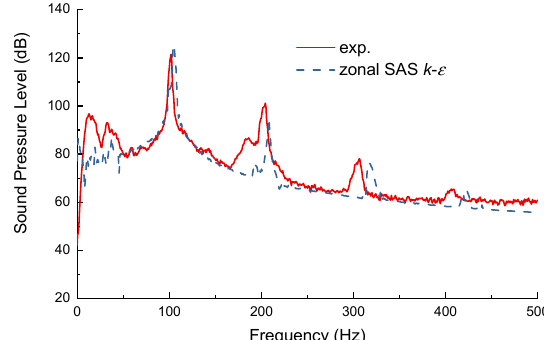
Figure 4. Comparison between calculation results and test results at monitor point 2.